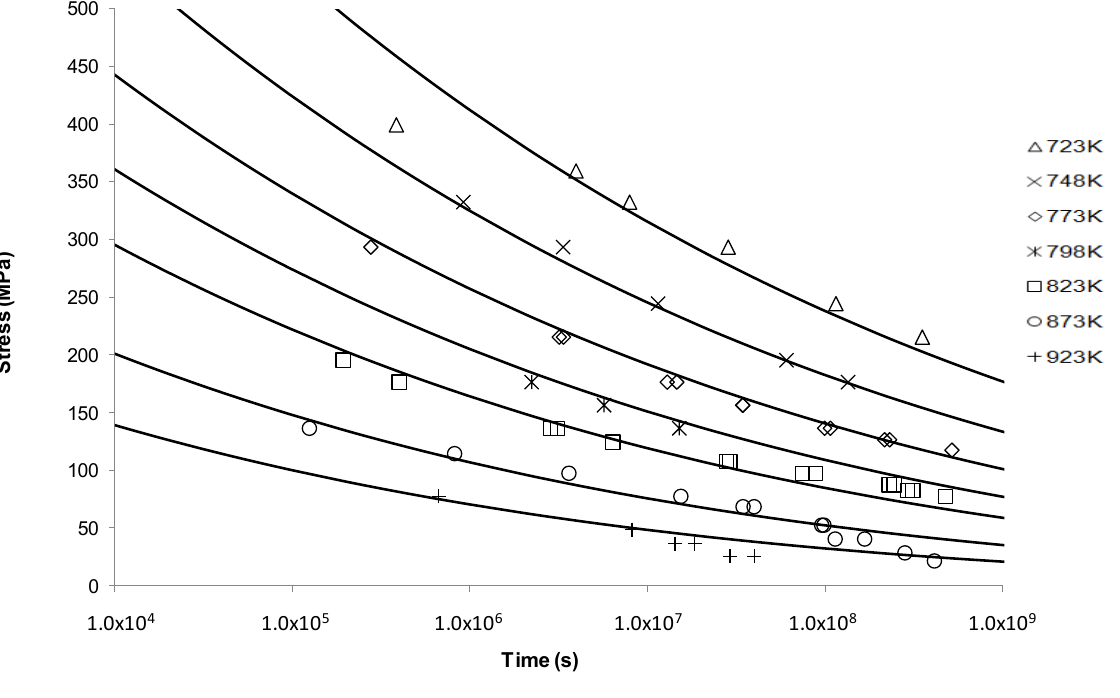
Figure 4. The Orr-Sherby-Dorn’s stress vs . time to fracture predictive curves using Grade 22 Steel creep